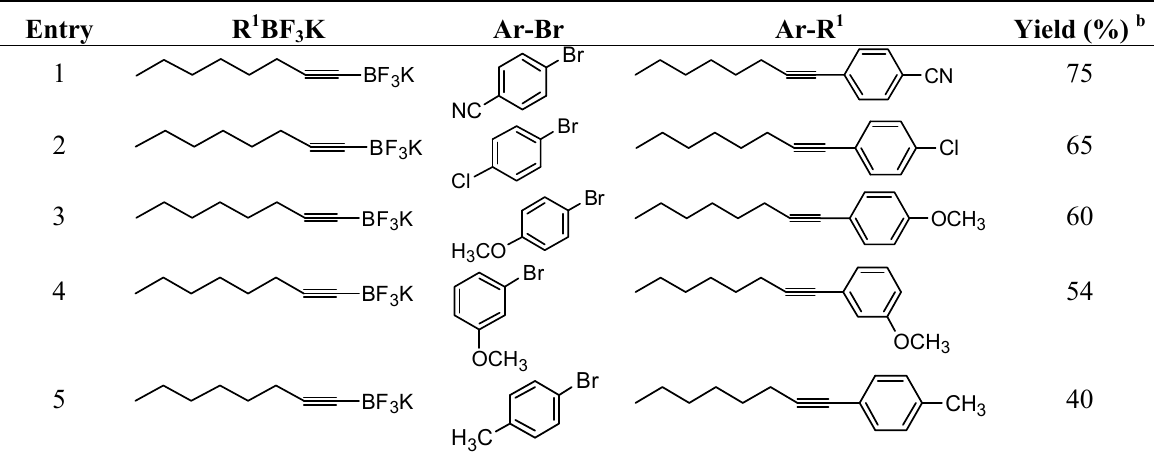
Table 1. Cross-coupling of aryl bromides with potassium octynyltrifluroborate a . Entry